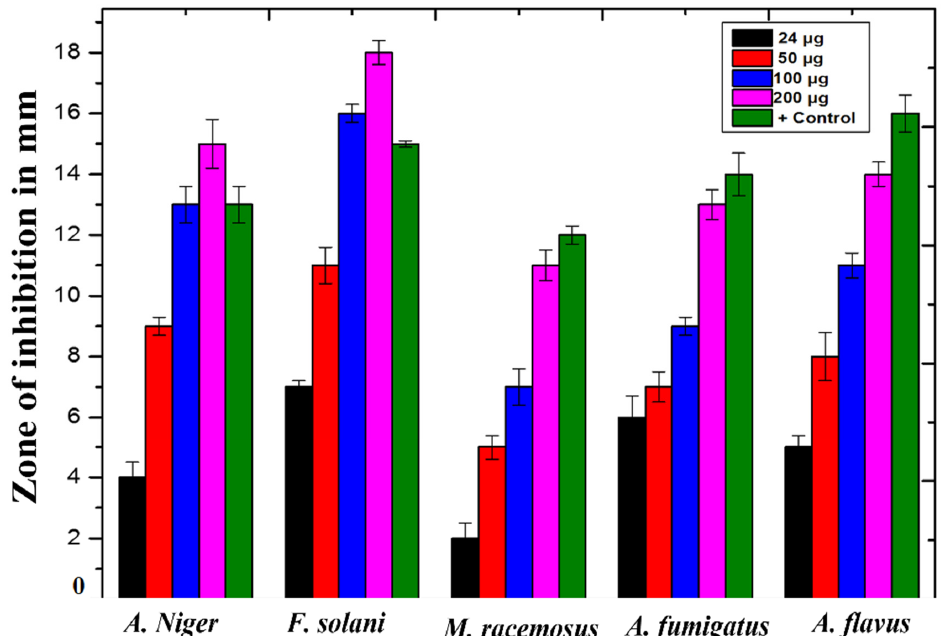
Figure 5. Antifungal activity of Monotheca buxifolia synthesized ZnO-NPs.